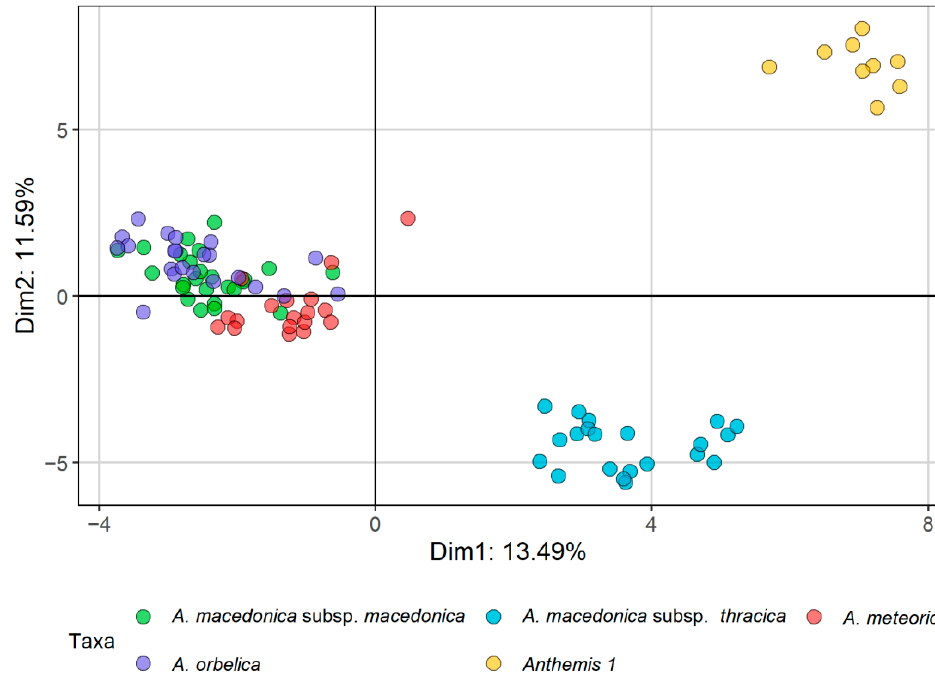
Figure 2. Factor analysis (FAMD) of the Anthemis macedonica group, based on 20 quantitative characters, three ratios and 19 qualitative characters.